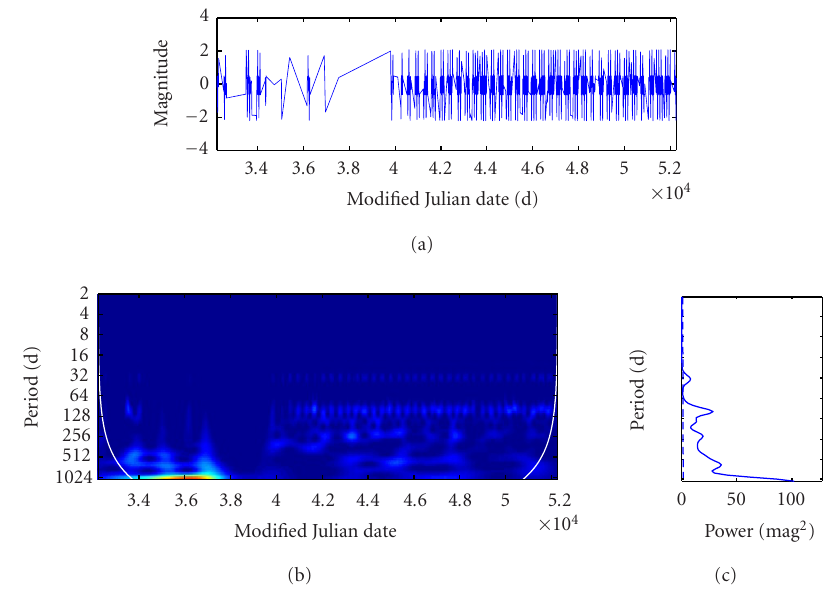
Figure 6: (a) Simulated signal built from the RV Tauri sampling (light curve). (b) Wavelet power spectrum. The continuous white line indicates the cone of influence. (c) Global wavelet spectrum of the simulated signal with a Morlet wavelet. The 95% confidence level that could be obtained for a white noise is shown by the dashed